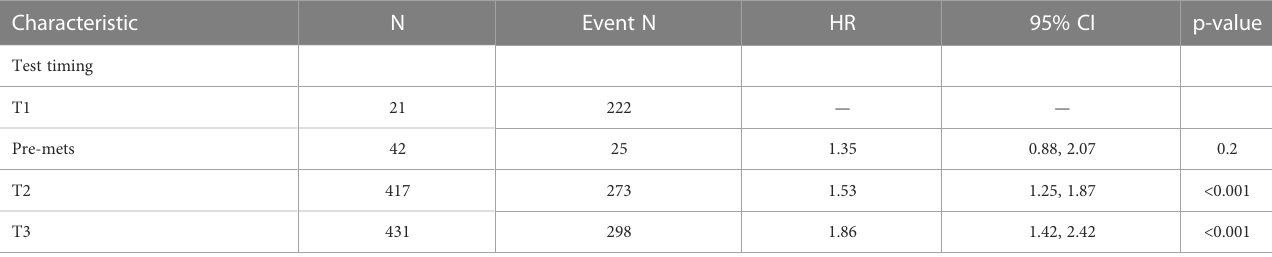
TABLE 2 Cox proportional hazards regression model strati fi ed by diagnostic groups.